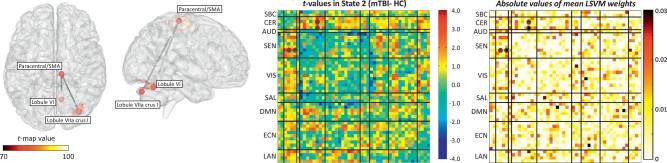
Connectivity difference results for State 2 evaluated using two-sample t-tests. Significance was corrected using false discovery rate (FDR) over the total of 1128 (48 ∗ 47/2) dFNC values on that state. Each displayed vertex represents a dFNC increment in mTBI compared to HC. No t-test survived FDR correction in any of the other three states. The matrix with all t-values for State 2 is displayed and the circles indicate the significant (FDR corrected) t-tests. The mean SVM weight vector is also displayed where similarities with the t-value matrix can be observed.